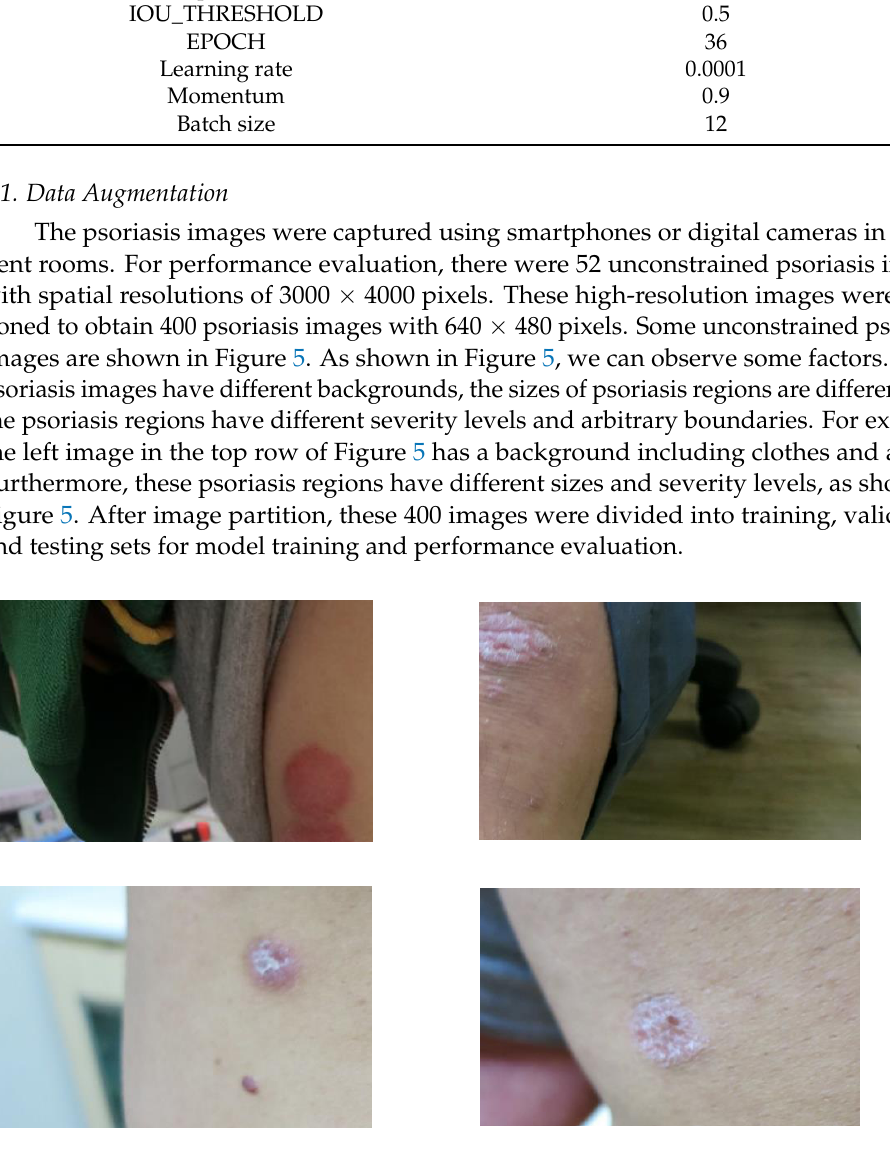
Figure 5. Examples of psoriasis images for performance evaluation.